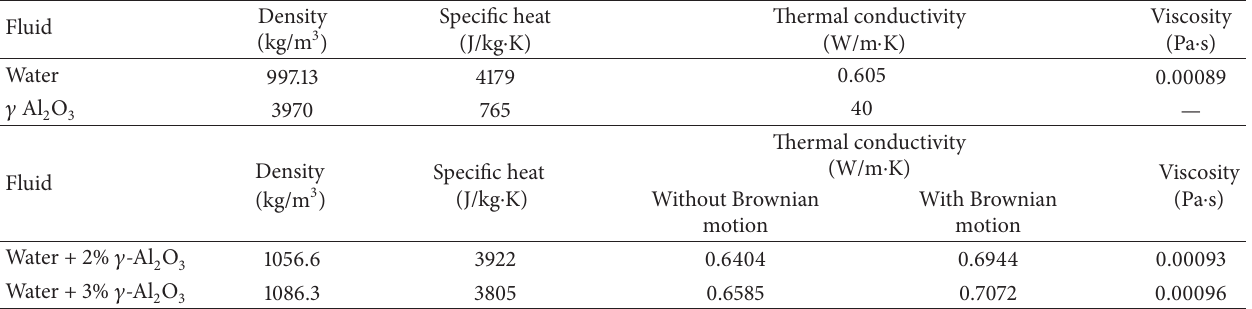
O nanofluids of different concentrations. 2 3